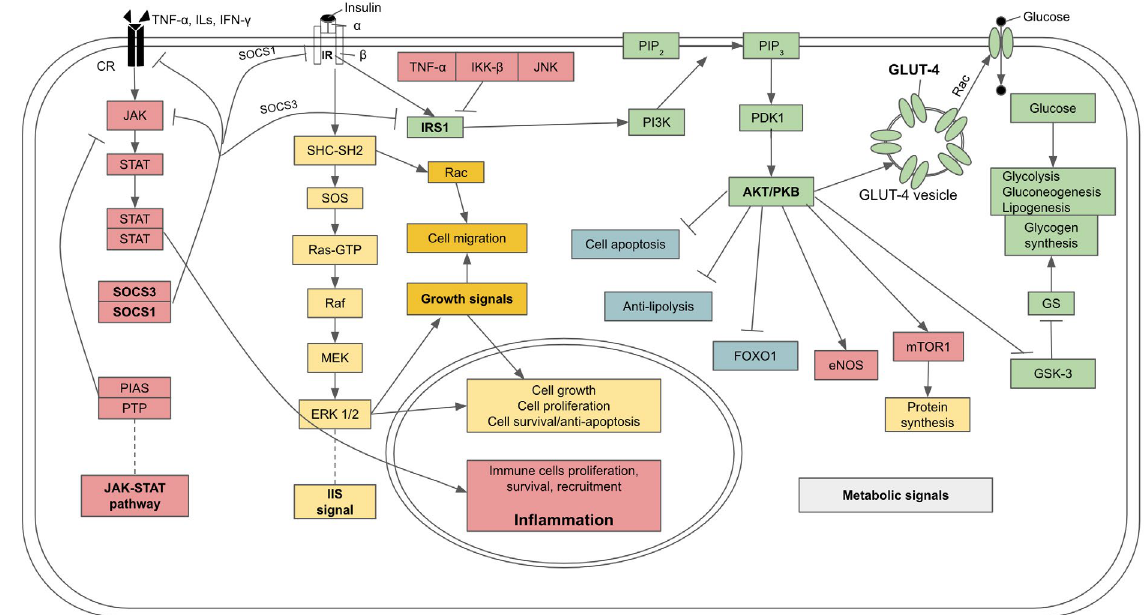
Figure 3. IIS pathway, its metabolic effects, and molecular mechanism of insulin resistance and diabetes due to the